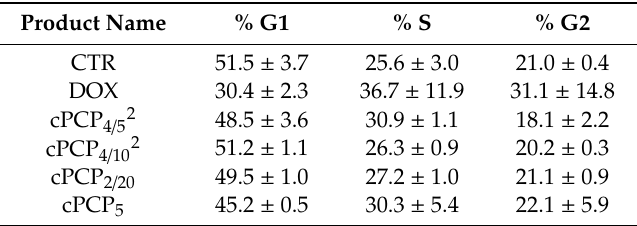
Table 2. Cell cycle analysis of HT1080 cells after 24 h of incubation with equimolar concentration (DOX eq) of free DOX and DOX-containing cPCPs. Results are presented as mean value ± S.D ( n =